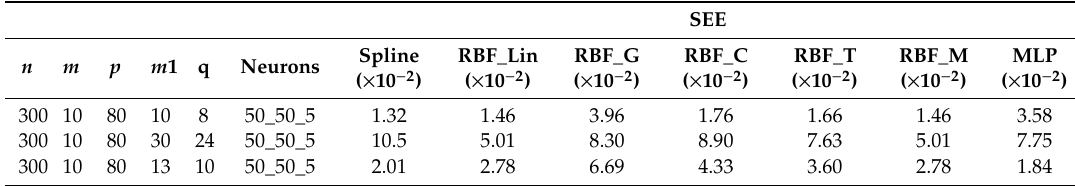
Figure 10. ( a ) Comparison of the three gap-filling methods: RBFs, Cubic spline and mono layer perceptron (50 50 5), (80 10 10). ( b ) Details of interpolations. Table 4. Comparison between spline, RBF’s and perceptron (50 50 5), (80 10 10), (LM) with ( n = 300, m = 10%, p = 80%).